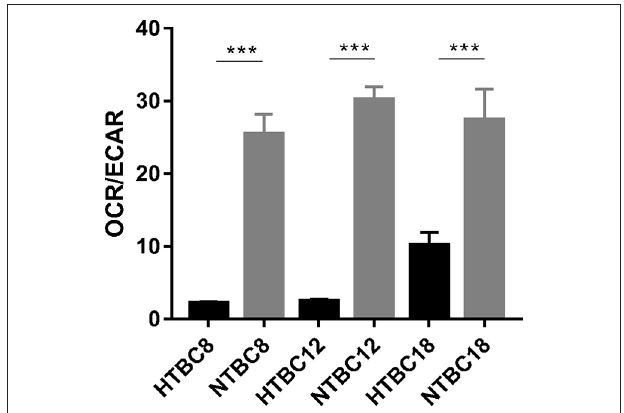
FIGURE 3 | Basal bioenergetic state of TBCs at different embryo developmental stages. The basal energy metabolism was assessed by analyzing OCR/ECAR ratios on days 8, 12, and 18 of incubation ( n = 3). HTBC, TBCs under hypoxia; NTBC, TBCs under normoxia. Data are indicated as the mean ± SEM. Asterisks represent significance compared to normoxia. *** P < 0.001.